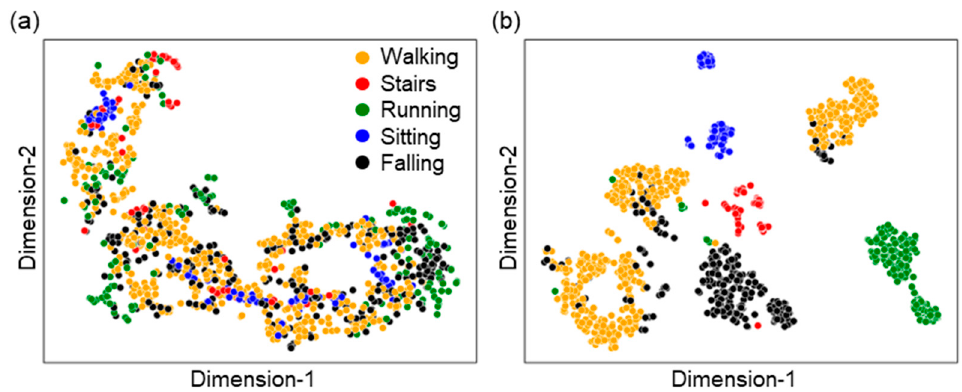
Figure 5. t-SNE to visualize the high-dimensional embedding learned by different features. ( a ) Raw features: XYZ acc. And gyro., 6 attributes (learning rate: 20, perplexity: 40) ( b ) after training the LSTM model, features taken from last hidden layer (learning rate: 10, perplexity: 30).